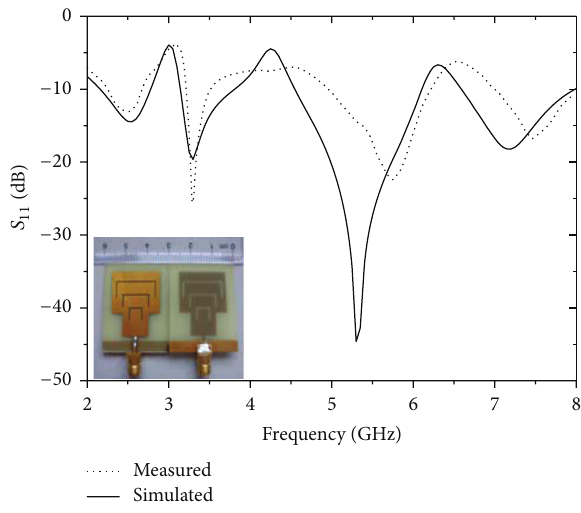
Figure 7: Frequency behavior of the simulated and measured 𝑆 11 parameter of the proposed multiband